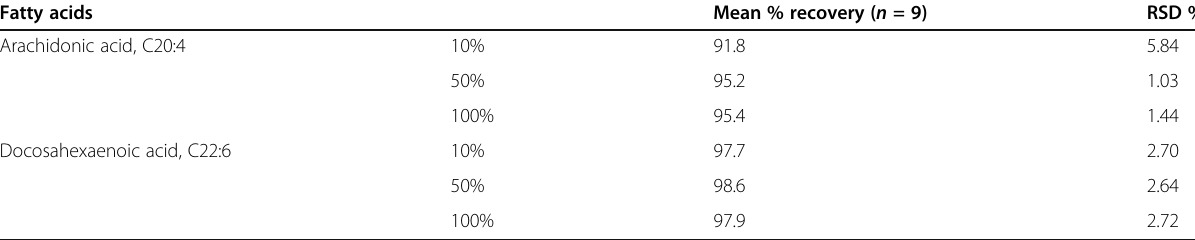
Table. 3 Accuracy results for lipid extraction Fatty acids